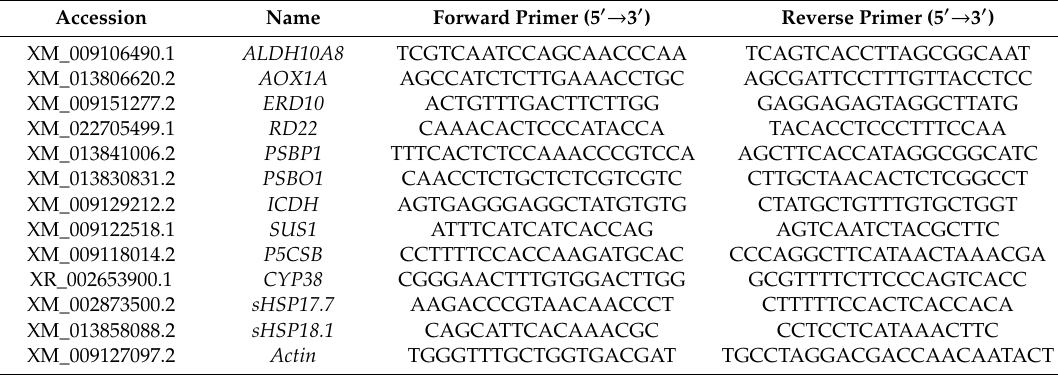
Table 1. Primers used for fragment amplification of di ff erentially expressed